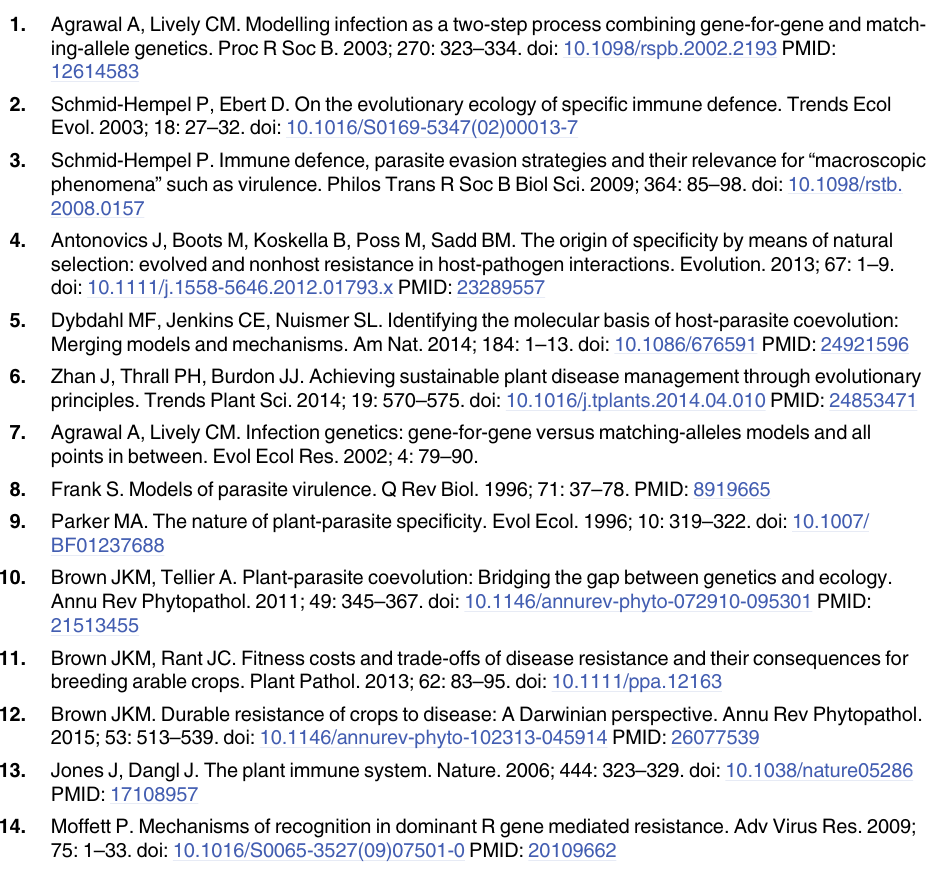
S11 Fig. Phylogeny of pvr2/eIF4E1 coding sequences in the genus Capsicum based only on the third positions of the codons. The presented phylogeny was reconstructed by the NJ method, bootstrap values (1000 replicates) are indicated on the nodes. hapA to hapQ are pvr2/ eIF4E1 haplotypes identified in chiltepin populations; pvr2 + and pvr2 1 to pvr2 9 are pvr2/eIF4E1 haplotypes described in [23]; pvr1 + , pvr1 and pvr1 2 are described in [22]; pvr2 10 to pvr2 22 are described in [45]; pot1 + : Potyvirus susceptibility allele from tomato (accession number AY723733). Green label: susceptible allele; red label: resistant allele; grey label: not character- ized allele.